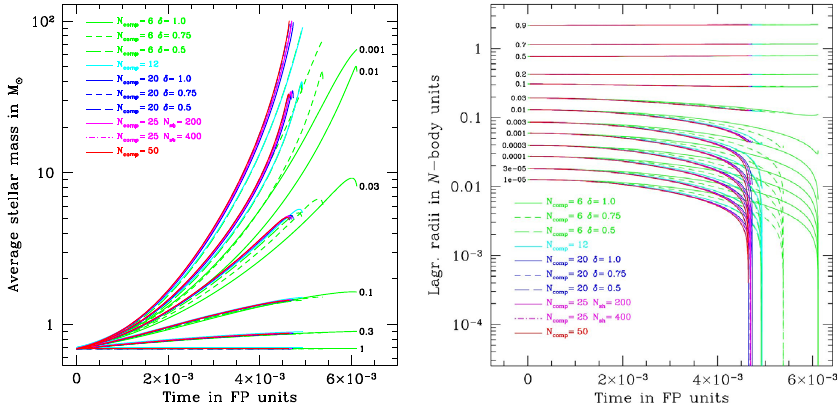
Fig. 30 Lagrangian radii and average stellar mass for 10 models with different mass spectrum (see text for details)